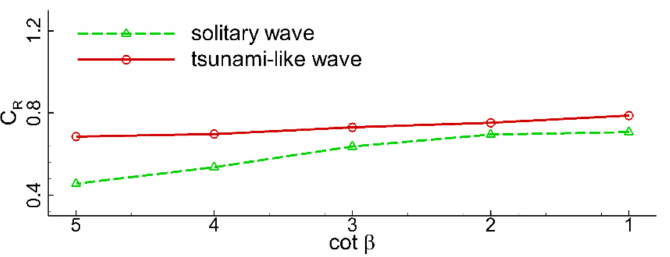
Figure 28. Variations in the wave reflection coefficient with the side slopes of the seawall.